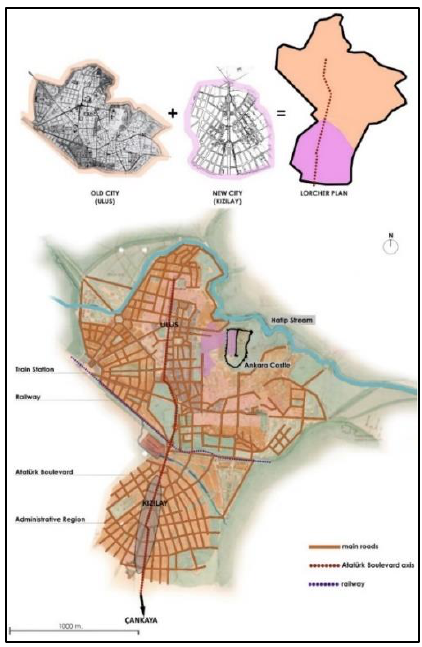
Figure 8 Lörcher’s Planning Period (1924 -28) & spatial analysis.